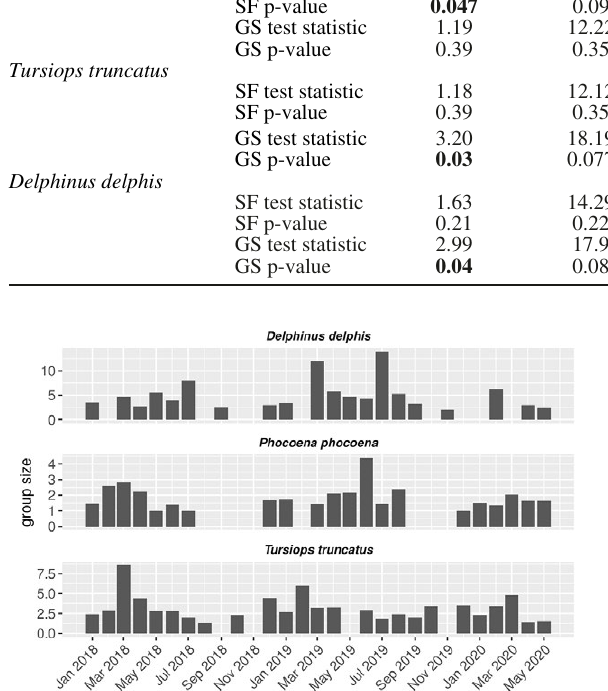
Fig. 5. – Dynamics of mean group size for three cetacean species observed in the study area from January 2018 to May 2020.